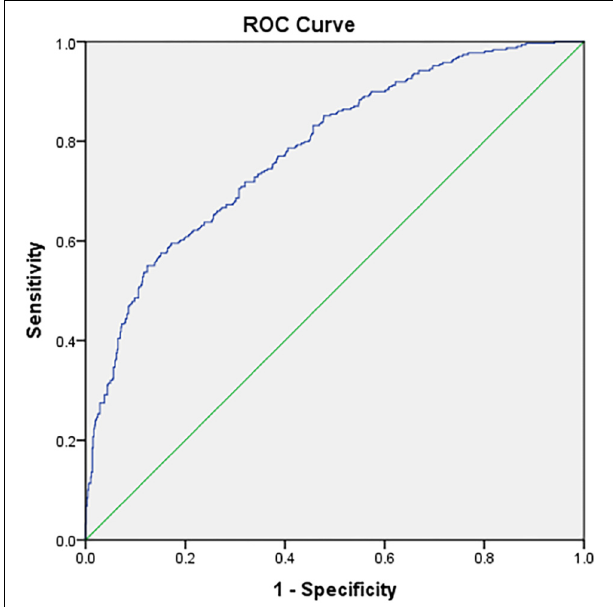
FIGURE 2 | ROC curve for the stopping rule SE( θ ) < 0.3 or length(item) = 13 in the stress